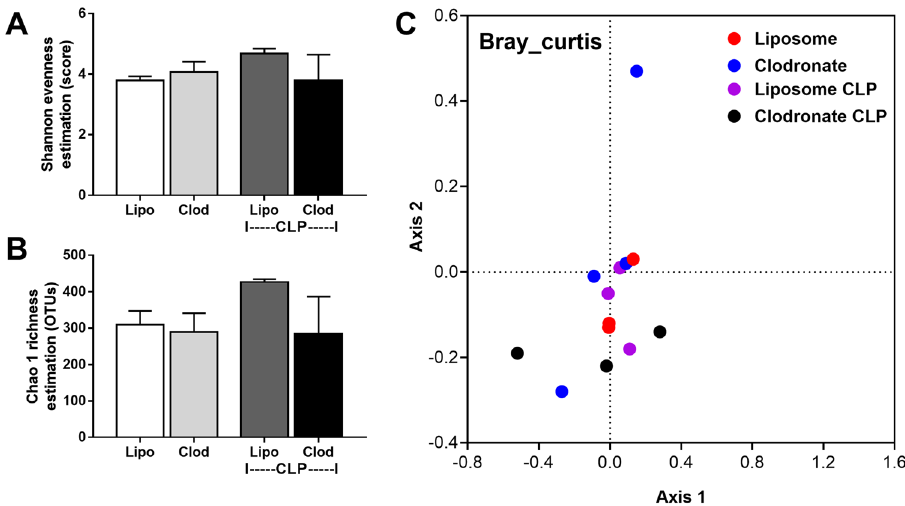
Figure 8. Bacterial microbiome analysis from feces of mice with liposomal clodronate (Clod) or liposome control (Lipo) at 24 h after cecal ligation and puncture (CLP) surgery as indicated by alpha diversity (Shannon and Chao) ( A , B ) and beta diversity (Bray Curtis) ( C ) are